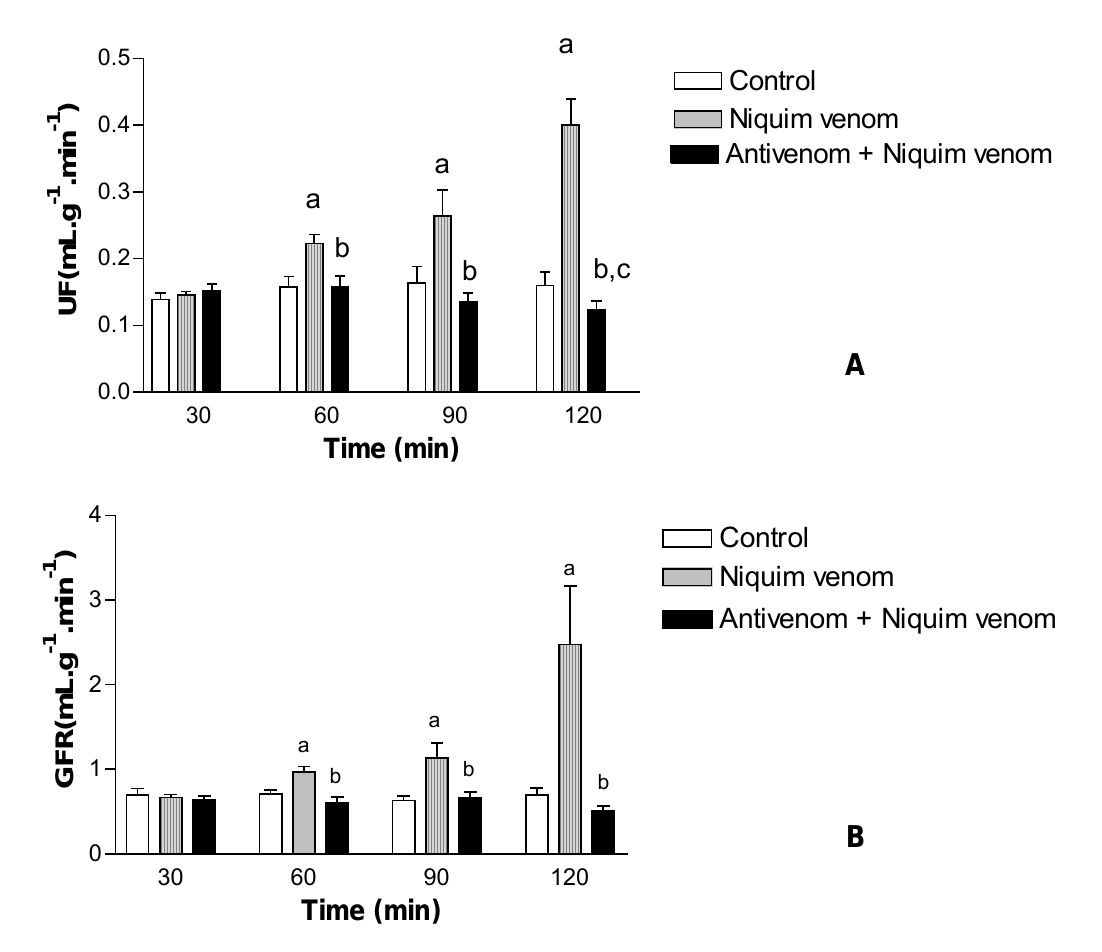
Figure 2. Action of the antivenom (1 µg/mL) on niquim venom effects (1 µg/mL) on urinary flow (UF; A ) and glomerular filtration rate (GFR; B ). Data are expressed as means ± SEM from six different animals. ANOVA was employed for statistical analysis by comparison with the control group in which kidneys were perfused with only MKHS with a,b,c p <